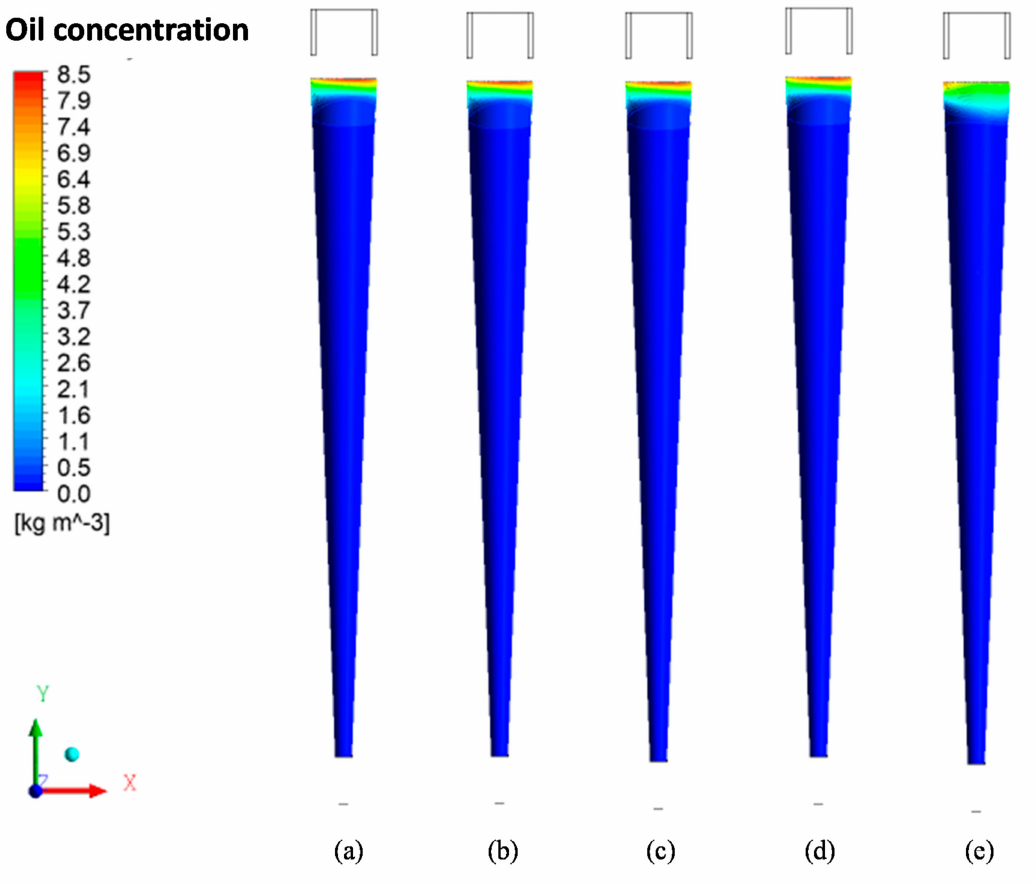
Figure 11. Oil concentration fields on the membrane wall for different values of the membrane rejection coefficient: ( a ) R = 0.96;